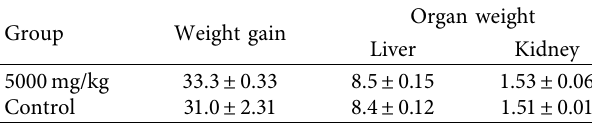
Table 1: Weight gain and organ weight of rats: acute toxicity